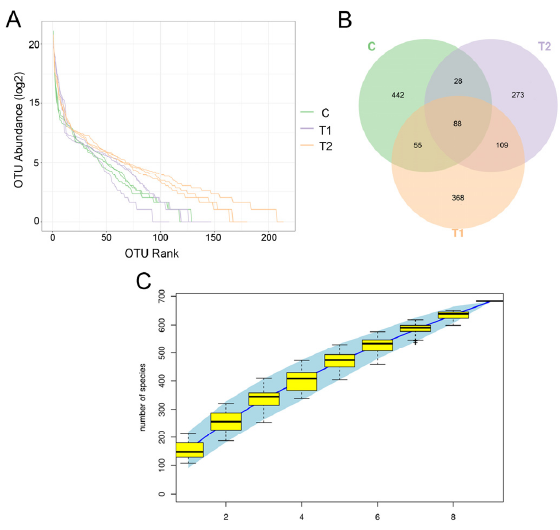
Figure 4. Rarefaction curves, Venn diagram, and rank abundance curve of different treatment groups of gibel carp exposed to aflatoxin B1 for 28 days. ( A ) Rarefaction curves. ( B ) Venn diagram representing the operational taxonomic units (OTUs) shared among treatment groups. ( C ) Rank abundance curve. C: control diet, T1: 50 µg/kg AFB1, T2: 100 µg/kg AFB1.